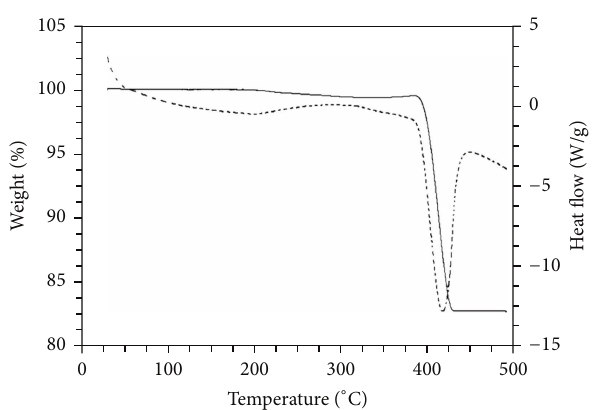
Figure 2: TGA (solid line)/DSC (dotted line) plots of uncalcined sample prepared with 0.008 M SDS at 180 ∘ C for 4 h.